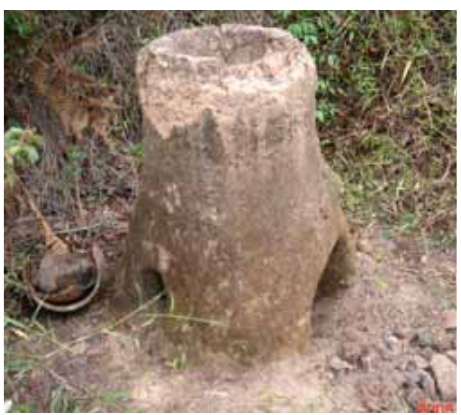
Fig 5: The pottery of the Nundu SE2